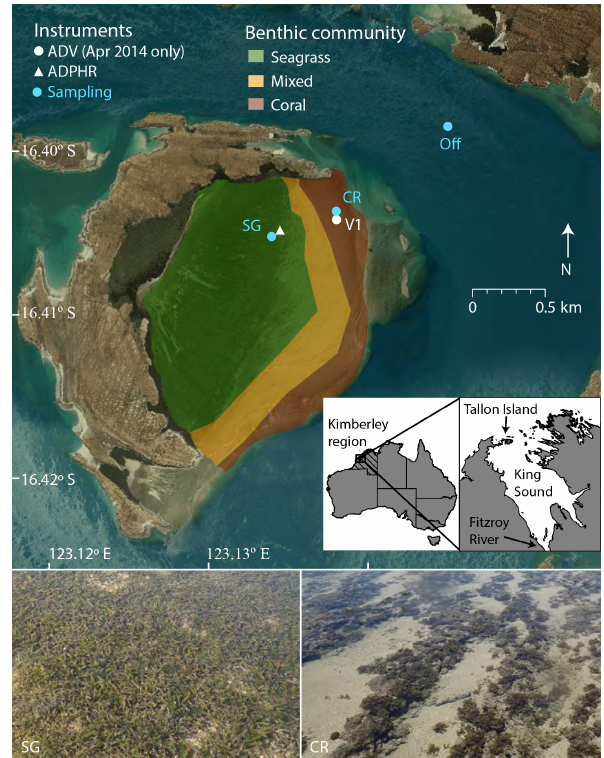
Figure 1. Deployment locations of hydrodynamic instrumentation and water sampling locations on the Tallon reef platform and off- shore. Inset shows Tallon Island location in the western Kimberley region of Australia. ADV refers to acoustic Doppler velocimeter and ADPHR refers to acoustic Doppler